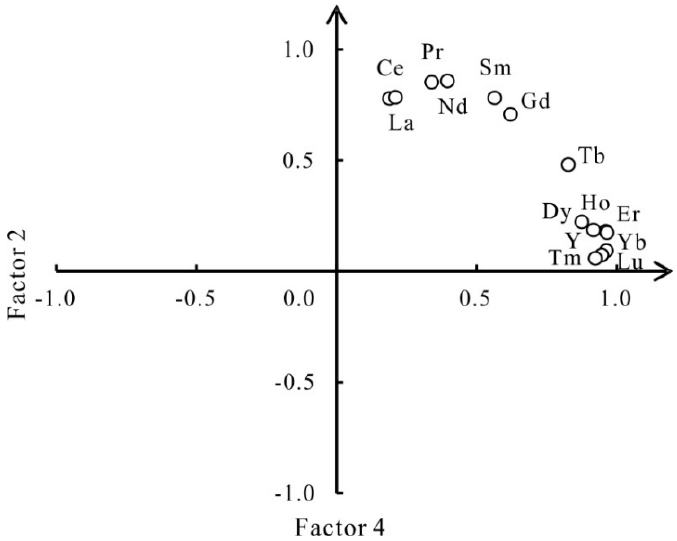
Figure 8. Biplot of Factor 2 vs. Factor 4 indicating the fractionation of LREEs and HREEs. Circles indicate